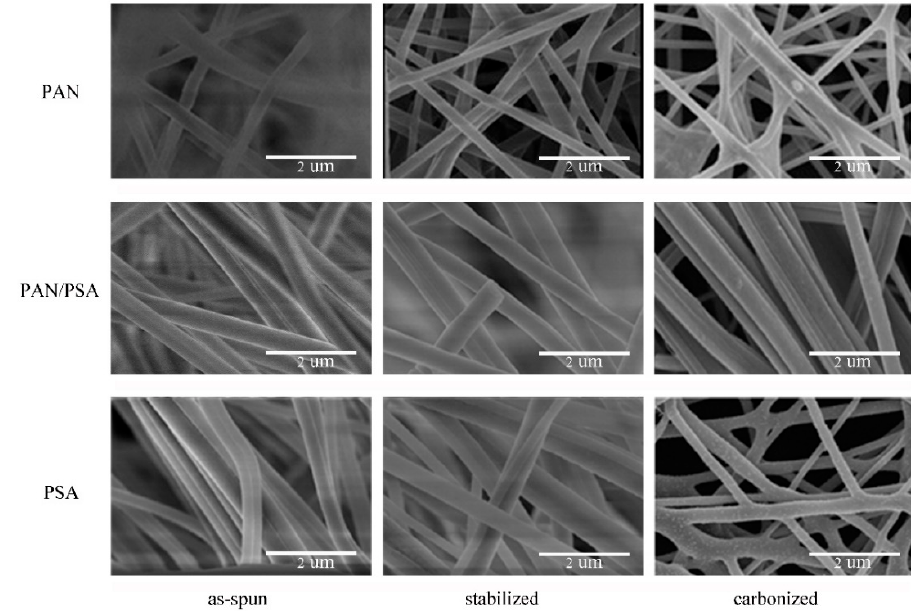
Figure 10. SEM image of membranes of different materials at different processing stages: as-spun, stabilized, carbonized.